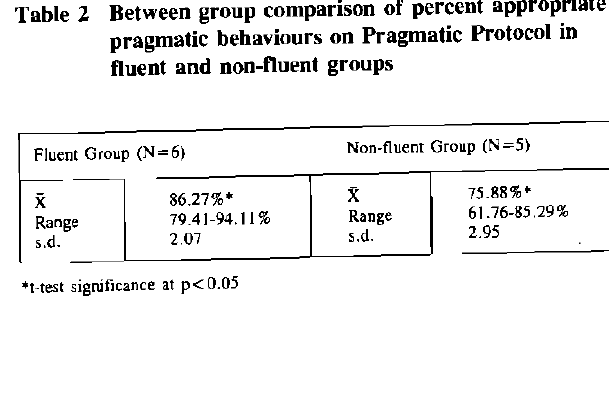
Table 2 Between group comparison of percent appropriate pragmatic behaviours on Pragmatic Protocol